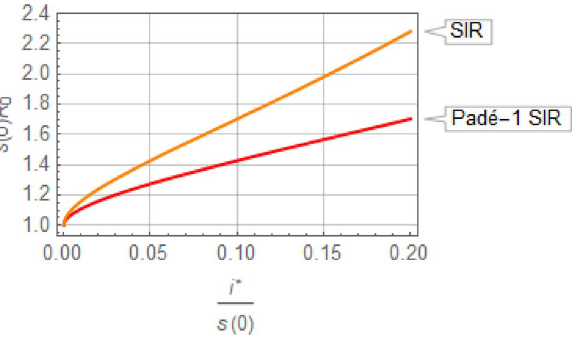
Figure 8. Maximum value of R 0 indicated by the Padé SIR and SIR models for i not to exceed i ∗ when s ( 0 )